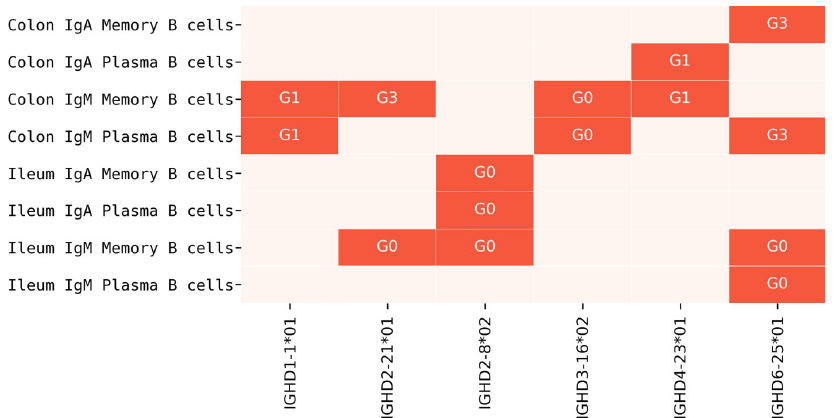
Fig 13. Summary of overused genes in Intestinal datasets. The datasets in which each gene is overused are highlighted and annotated with the corresponding individuals. The subjects in the Intestinal Repertoire project were prefixed with